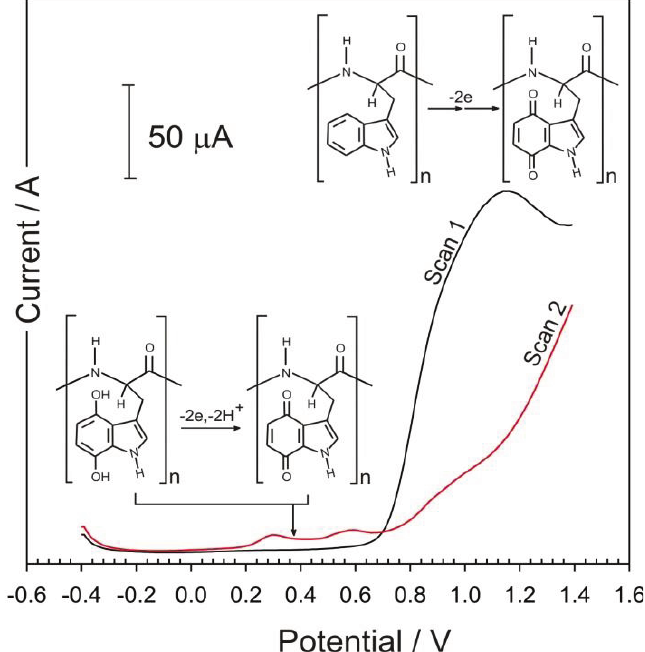
Figure 5. Square wave voltammograms detailing the first and second scans of the poly-tryptophan carbon fibre composite sensor.